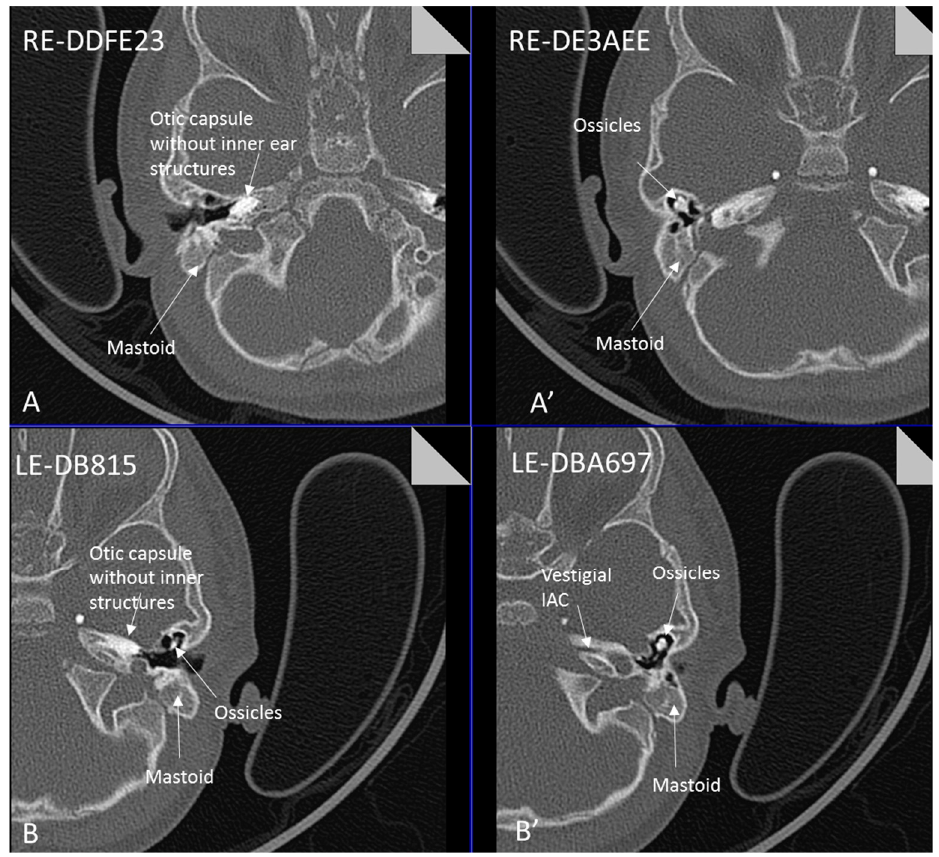
Figure 2. Axial CT petrous bone in patient 8 of the right ( A , A’ ) and left ( B , B’ ) ears shows complete labyrinthine aplasia (Michel deformity) characterised by absence of the inner ear structures: cochlea, vestibule, semicircular canals and vestibular and cochlear aqueducts. The otic capsule is hypoplastic and only a vestigial IAC is observed in the left ear ( B’ ). Middle ear ossicles are bilaterally present and normal.